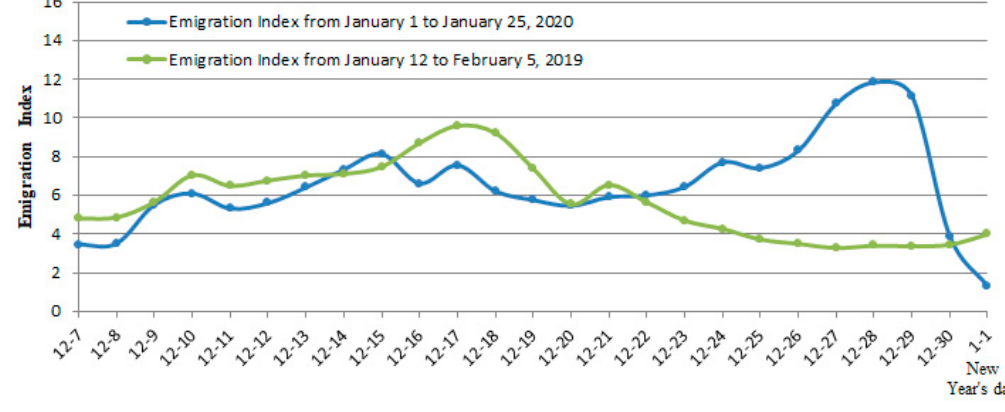
Figure 3. Emigration index in 2020 and 2019.